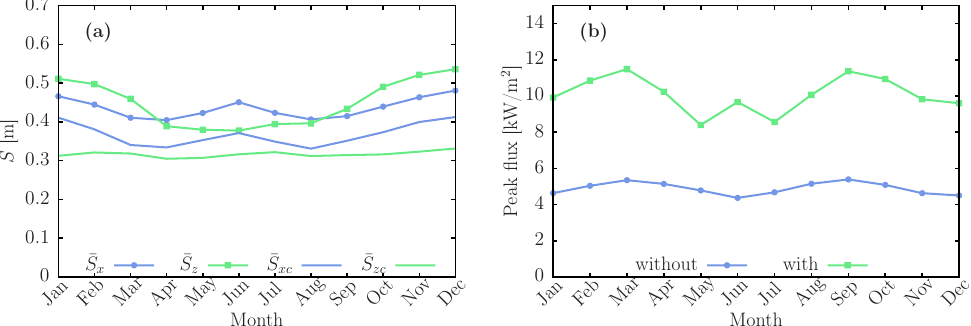
Figure 11. Behavior of the daily standard deviations ¯ S ( a ) and the peak flux ( b ) for H8 arrays with and without concentrating mirrors. Location is at 37 m from the